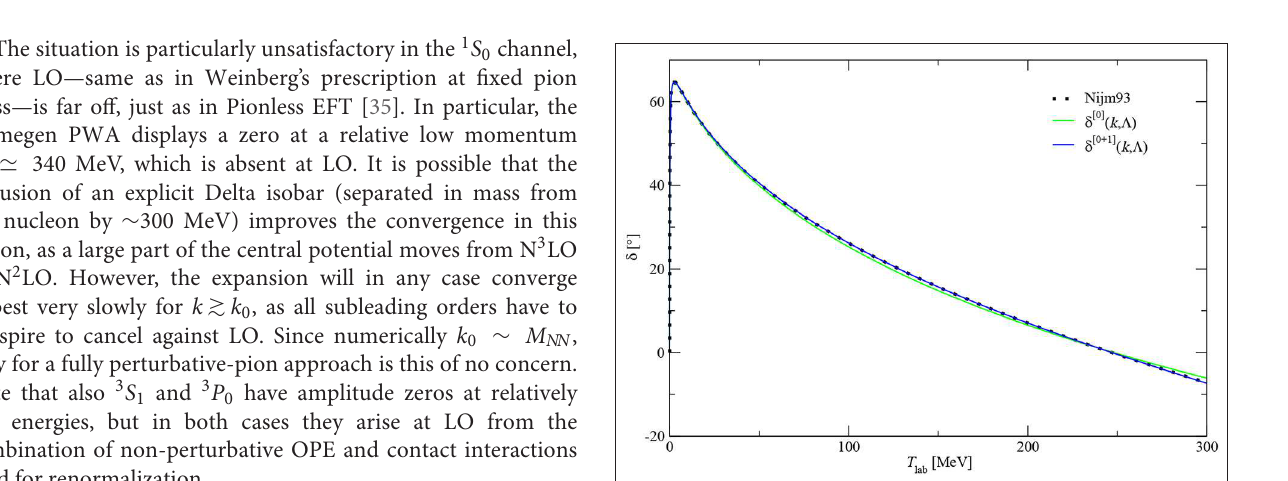
FIGURE 7 | Two-nucleon 3 P 2 - 3 F 2 phase shifts ( δ ) and mixing angle ( ε 2 ) as functions of the center-of-mass momentum k c.m. . The NLO (blue), N 2 LO (green), N 3 LO (orange), and N 4 LO (red) bands from a perturbative treatment of pion exchange correspond to cutoff variation from 0.8 to 4.8 GeV. N 2 LO results for 3 shown (triangles) (LO in a perturbative expansion vanishes for these channels.) The empirical phase shifts from the SAID program [88] (solid circles) are shown for comparison. Reprinted figure with permission from reference [87]. Copyright (2019) by the American Physical Society.